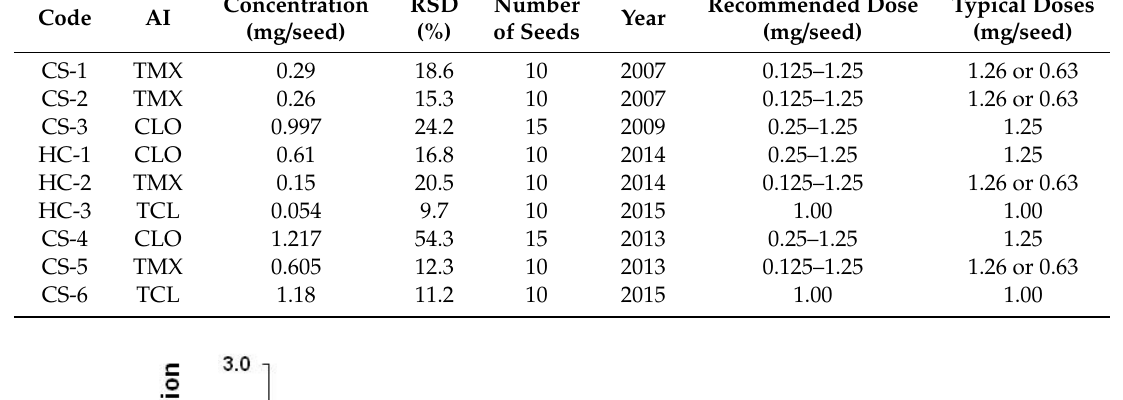
Table 1. The concentration of neonicotinoid active ingredients (AIs) in seed coating of maize seeds.